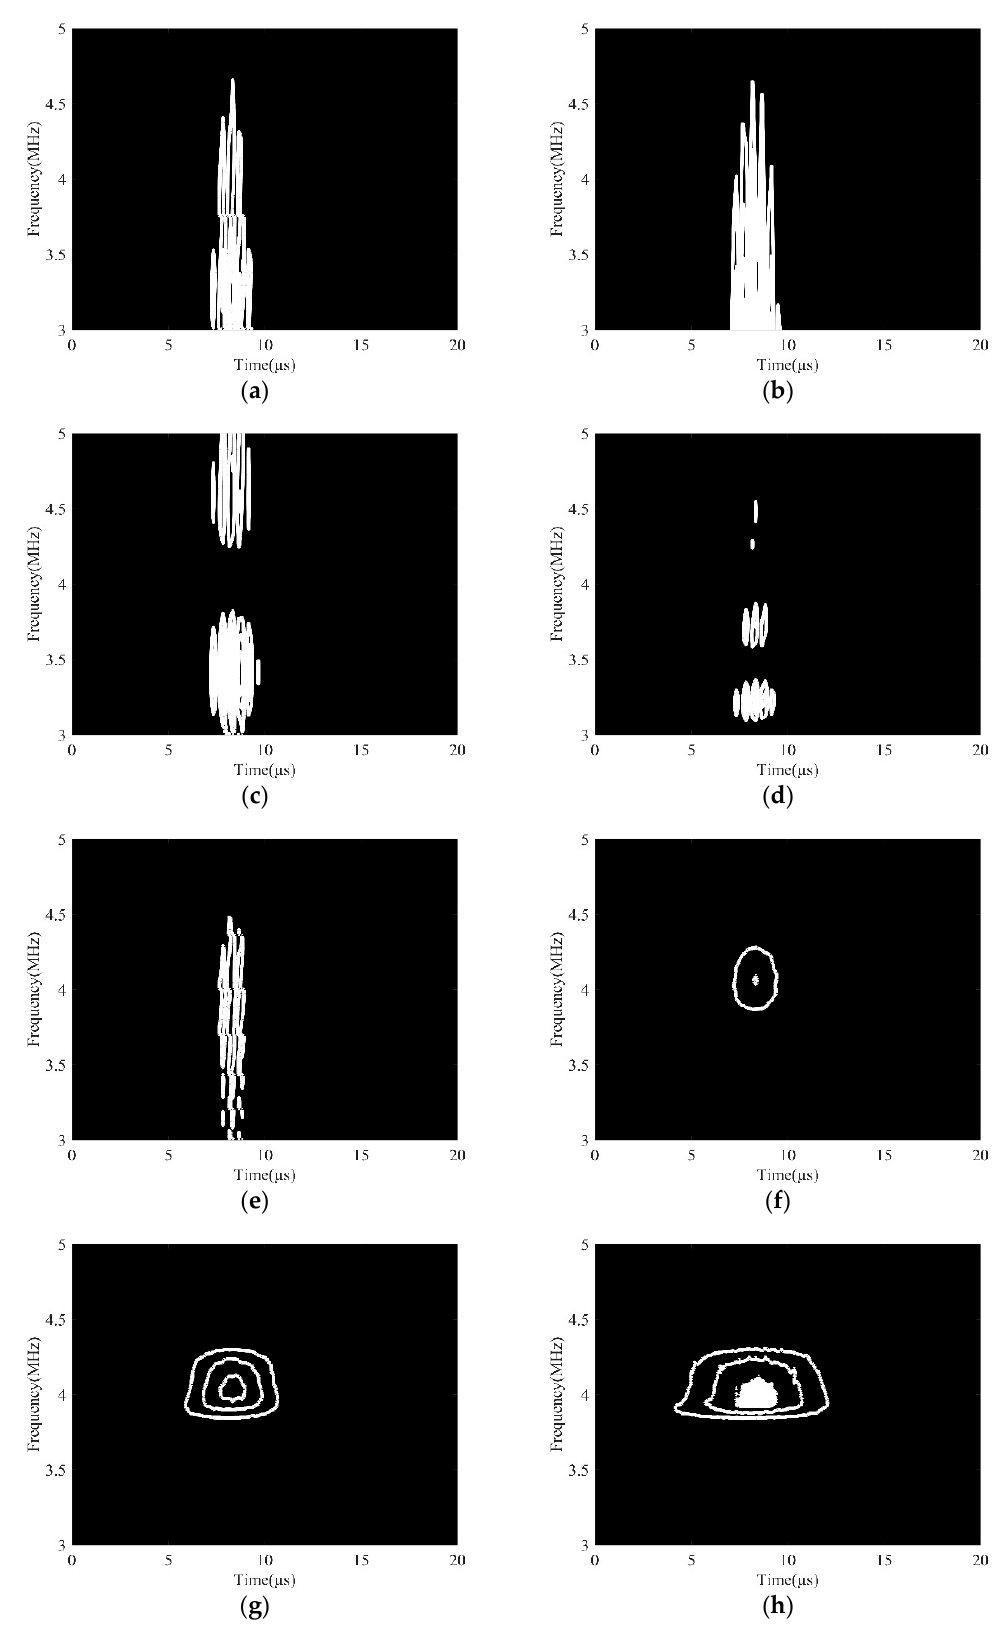
Figure 4. DWFP images of different wavelet functions. ( a ) Cgau4; ( b ) Haar; ( c ) Mexh; ( d ) Sym6; ( e ) Cmor1-1; ( f ) Cmor3-3; ( g ) Cmor5-5; ( h ) Cmor7-7.